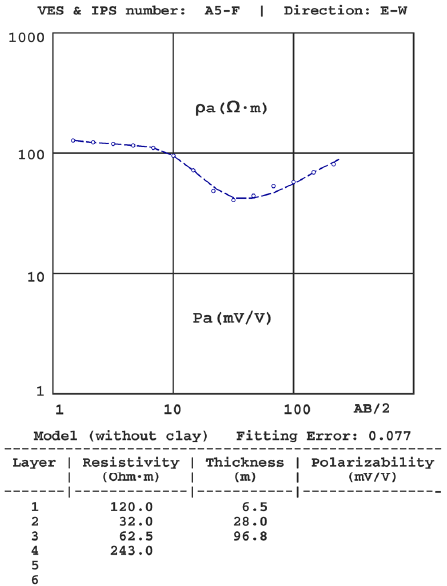
Figure 11. Results of the A5-F VES-IPS were obtained in late winter.